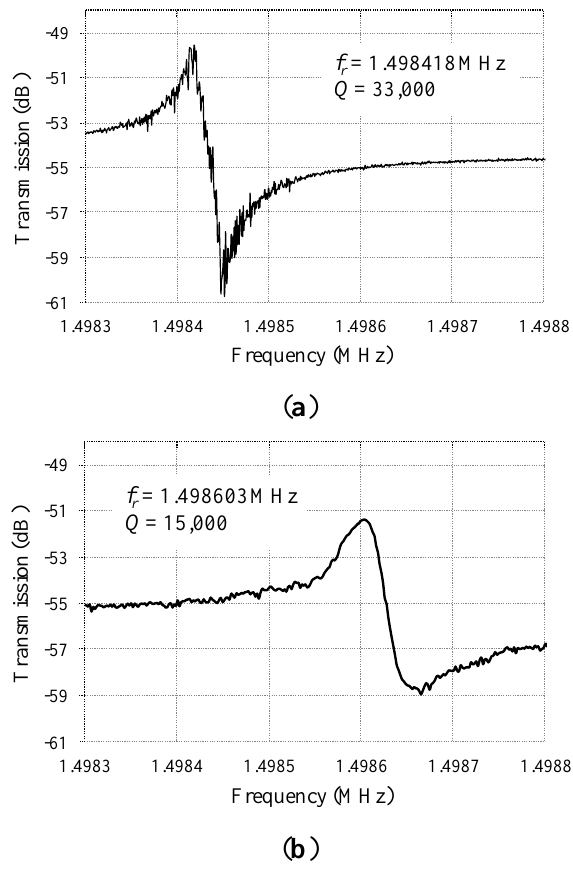
Figure 12. Measured resonance characteristics of the ( a ) drive mode, and ( b ) sense mode (10 mTorr